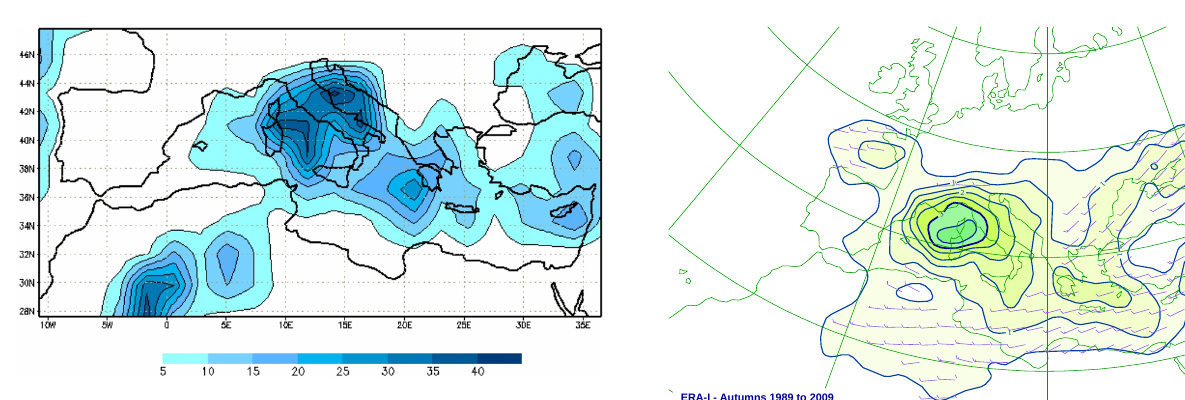
Figure 3. Geographical distribution of intense cyclones; that is, cy- clones with a geostrophic circulation larger than 7 × 10 7 m 2 s − 1 and with a duration of at least 24h. The isolines refer to the average number of cases per year, in 2.25 ◦ × 2.25 ◦ lat–lon squares. The data are based on ECMWF-ERA-40 reanalysis, 1957–2002 (Homar et al., 2007; courtesy of Joan Campins, AEMET; Uppala et al., 2005).